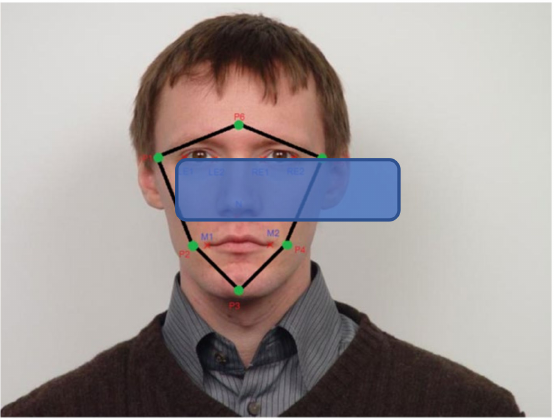
Figure 7. Facial border points defined by facial landmarks [25].